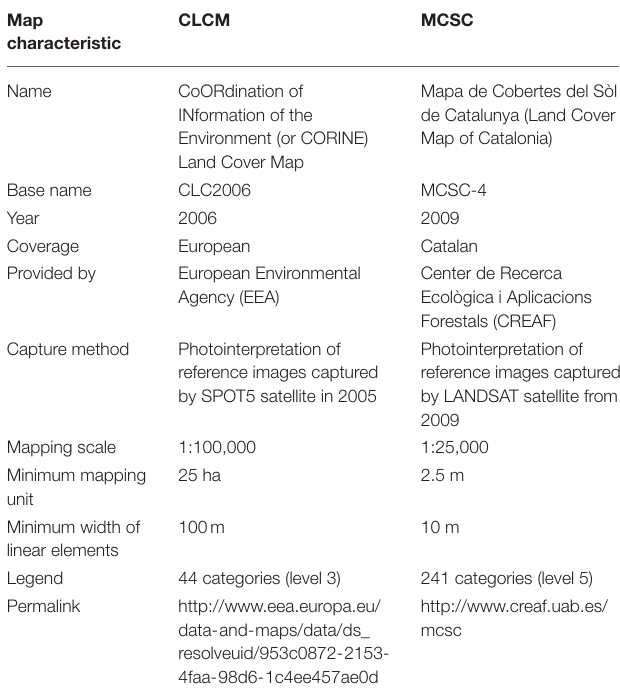
TABLE 4 | Characteristics of the 2006 Coordination of Information of the Environment land cover map (CLCM) and the 2009 Mapa de Cobertes del Sòl de Catalunya